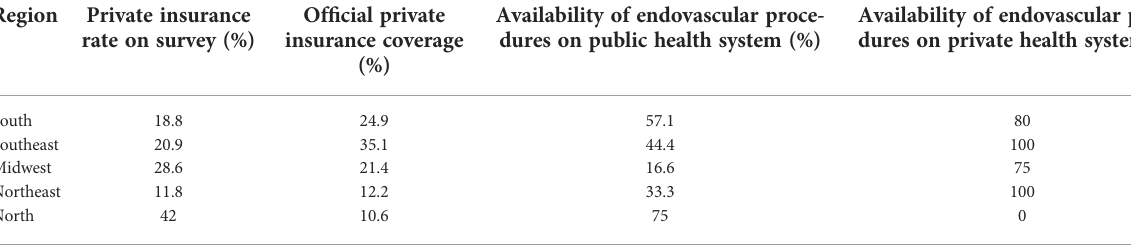
TABLE 5 Rates of private insurance coverage and availability of endovascular procedures by region.